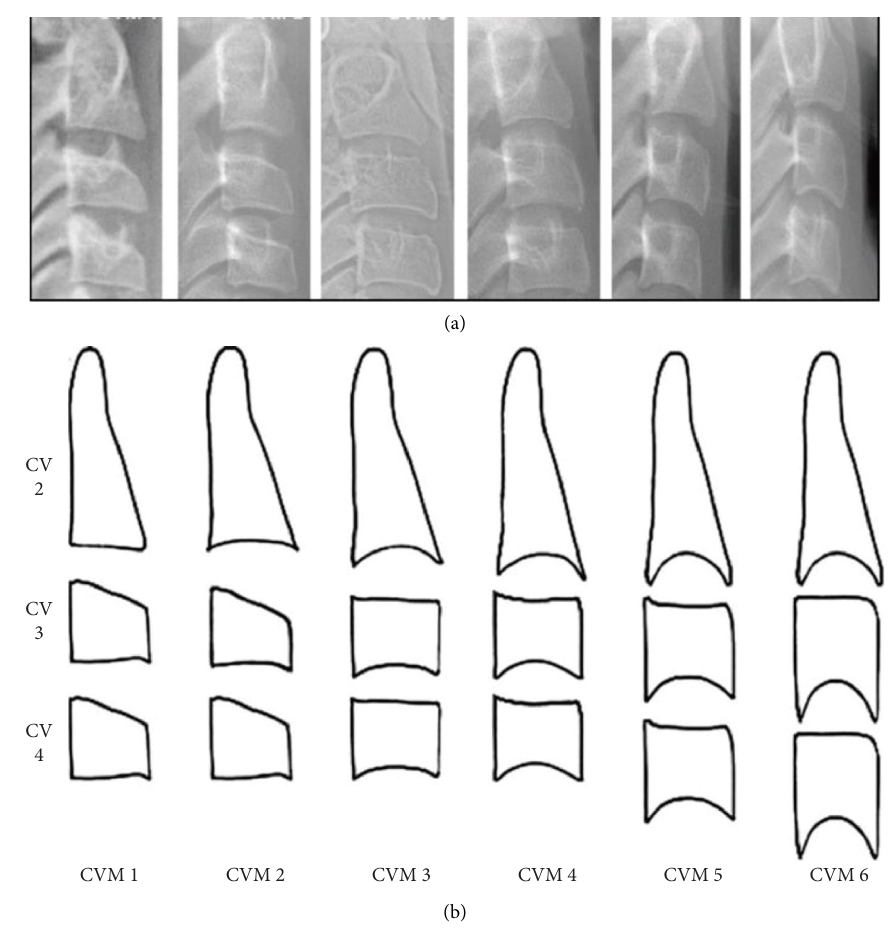
Figure 1: Bacceti’s method of determining cervical vertebral maturation stages for estimation of skeletal age. CVM 1: the inferior border of C2–C4 does not have any concavities. Te body of C3 and C4 is trapezoidal (the superior border of cervical vertebrae has a slope from the posterior towards the anterior). Maximum mandibular growth occurs around two years after this stage. CVM 2: concavity exists in the inferior border of C2. Te body of C3 and C4 is still trapezoidal. Maximum mandibular growth occurs approximately one year after this stage. CVM 3: concavity exists in the inferior border of C2 and C3. Te body of C3 and C4 may be trapezoidal or horizontally rectangular. Maximum mandibular growth occurs in less than one year after this stage. CVM 4: concavity exists in the inferior border of C2, C3, and C4. Te body of C3 and C4 is horizontally rectangular. Maximum mandibular growth has occurred one to two years prior to this stage. CVM 5: concavity still exists in the inferior border of C2, C3, and C4. Te body of at least one of the C3 and C4 is square-shaped. If not, it is horizontally rectangular. Maximum mandibular growth has ended at least one year prior to this stage. CVM 6: concavity still exists in the inferior border of C2, C3, and C4. Te body of at least one of the C3 and C4 is vertically rectangular. If not, it is square-shaped. Maximum mandibular growth has ended at least two years prior to this